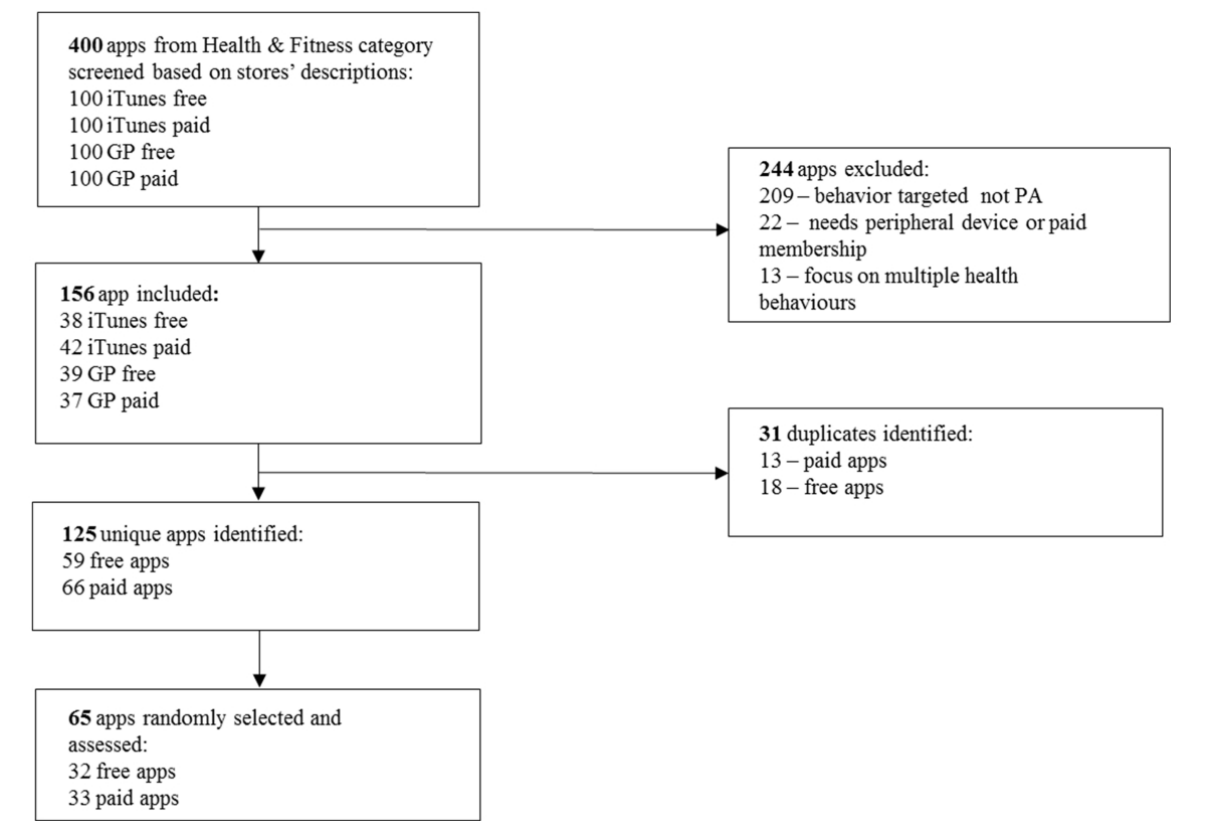
Figure 1. Flowchart of the apps included in the analysis. PA: physical